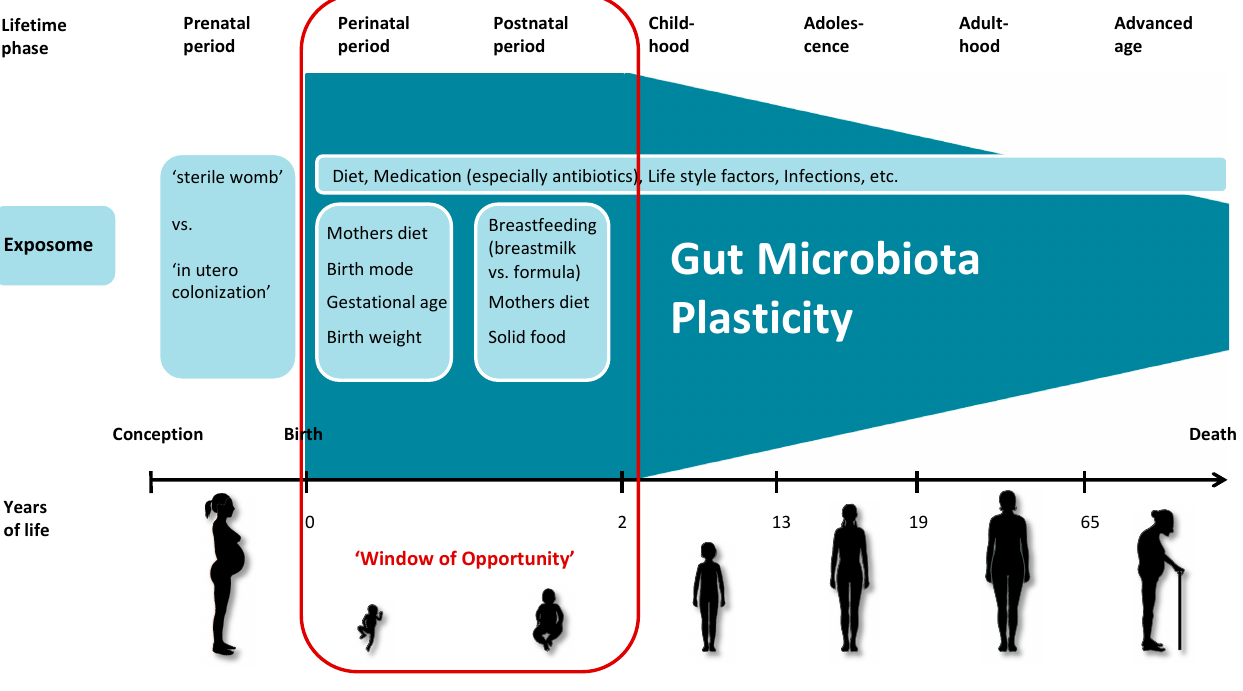
Figure 1. Simplified schema of the plasticity of the human gut microbiota throughout the life course. The microbiota is permanently imprinted by the exposome and subsequently functions as marker for the exposome. The exposome has the greatest potential to determine the microbial composition during the first two to three years of life, which are referred to as the ‘window of opportunity’ in this model. Throughout the life course, the microbiota becomes more stable; it largely returns to its previous state after transient environmental influences. The increase in stability leads to a decrease in the plasticity of the human gut microbiota. (The figure was produced using Servier Medical Art.) Compared to consuming breast milk, infants consuming formula display a greater diversity, in this case suggesting a less stable and uniform population of the gut